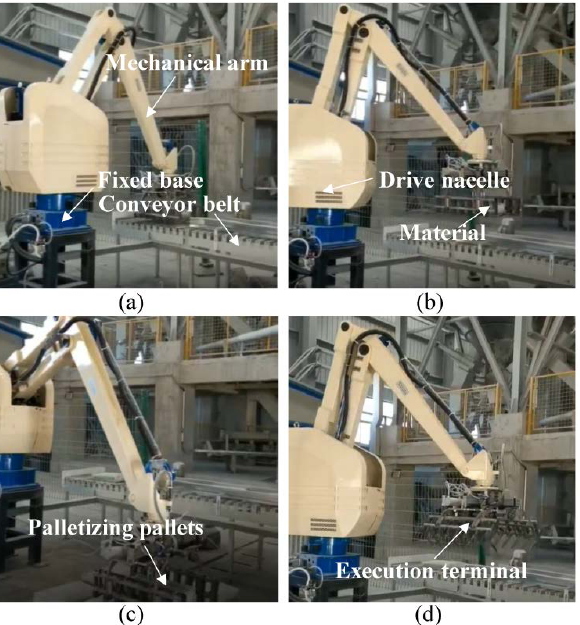
Figure 2. Palletizing robot workflow. ( a ) Grabbing of materials. ( b ) Transport of materials. ( c ) Place- ment of materials. ( d ) Returning